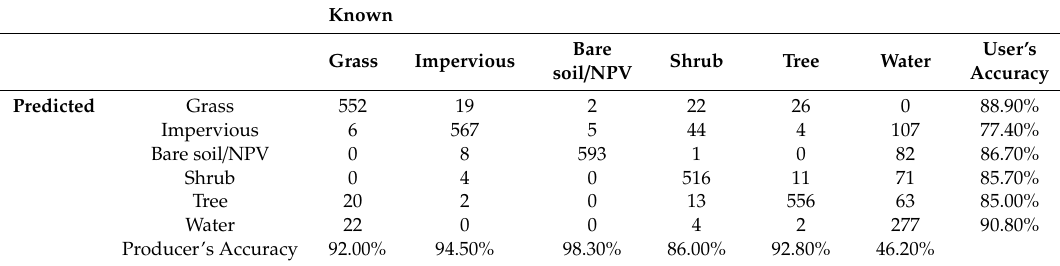
Table 3. Confusion matrix for NAIP / Sentinel-2 classification with overall accuracy of 85% and weighted overall accuracy of 88%.